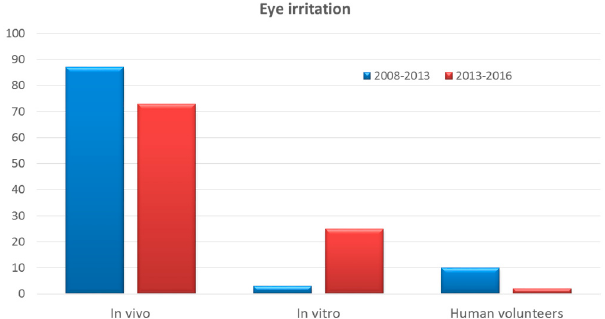
Figure 1. Evolution of the percentage of studies performed in vivo, in vitro and in human volunteers to evaluate the potential eye irritation of cosmetic ingredients-number of studies 82 (2008–2013) and 45 (2013–2016)